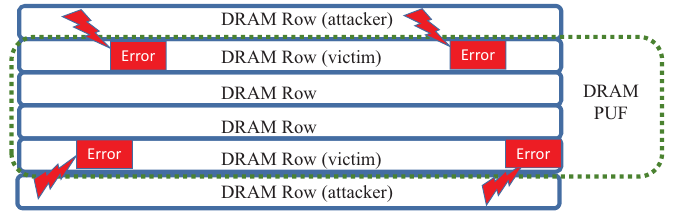
Figure 12. The rowhammer attacks for DRAM